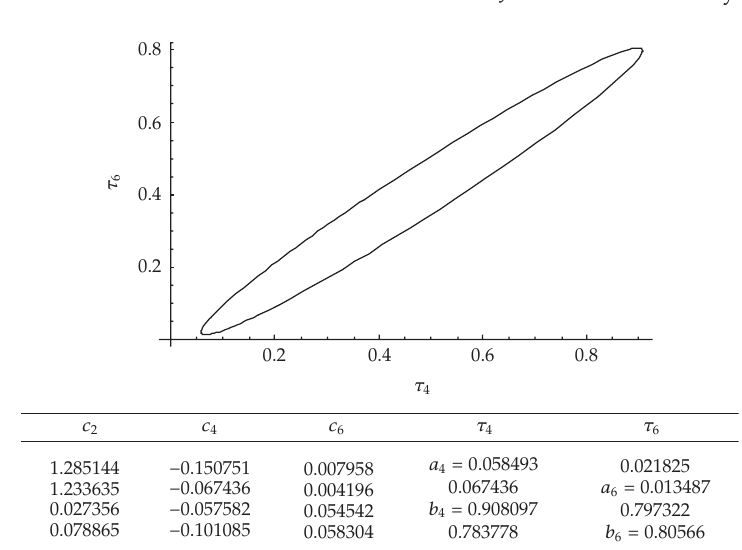
Figure 7: Boundary region and values of L- kurtosis τ 4 and τ 6 for symmetric fifth-order standard logistic- based power method pdfs. Valid pdfs exist inside the elliptical graph. Note that a 4 and a 6 are lower limits and b 4 and b 6 are upper